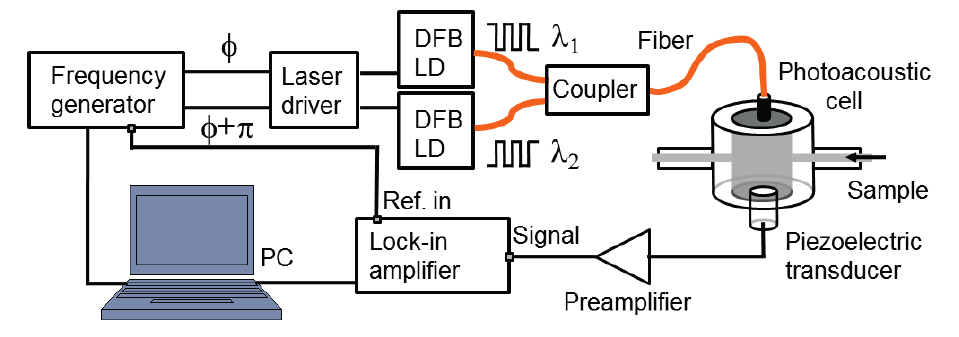
Figure 1. Schematic view of the experimental setup for OPBS-based